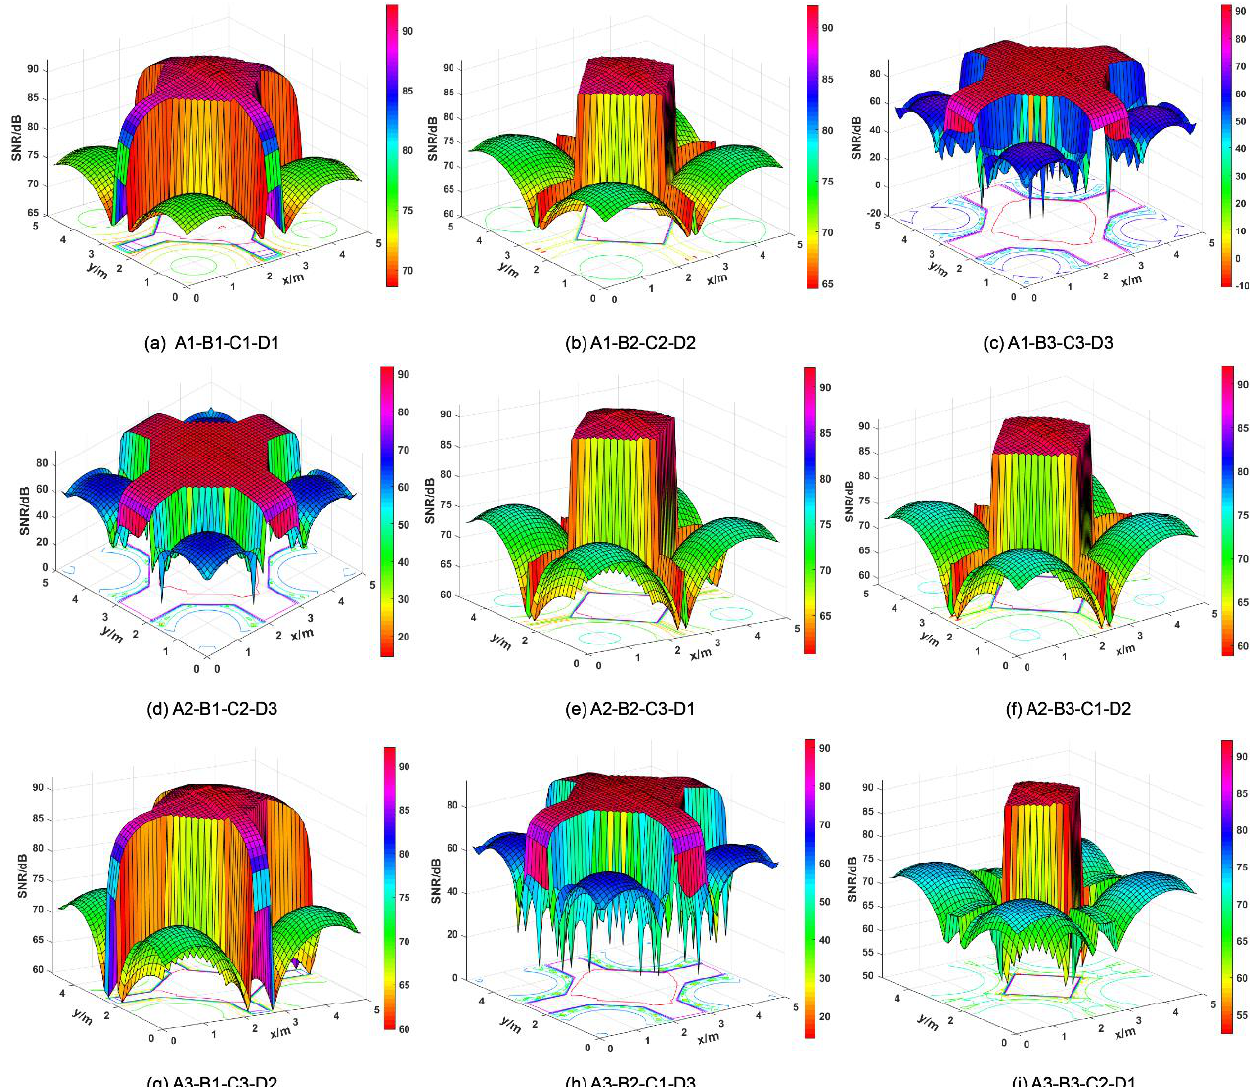
Figure 16. Diagram of the SNR distribution for different parameter combinations.